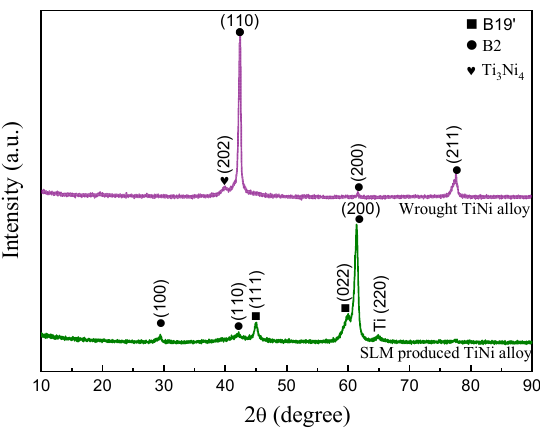
Figure 1. XRD patterns of wrought and SLM TiNi alloy.